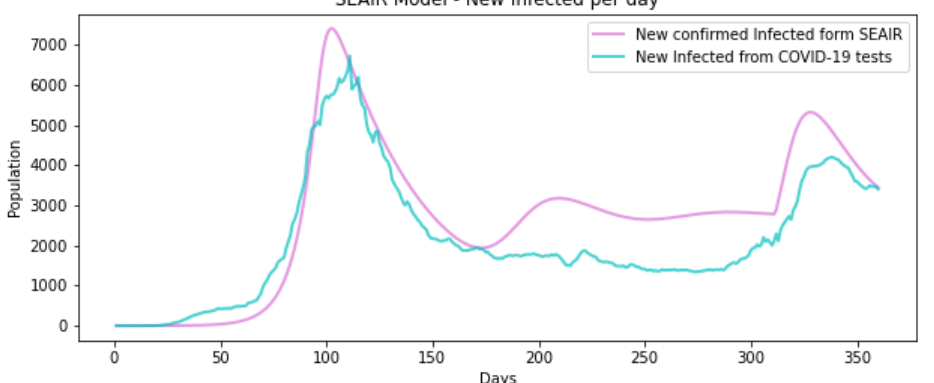
Figure 19. Comparison of newly infected people between SEAIR Model and COVID-19 tests in Chile. First and second wave.